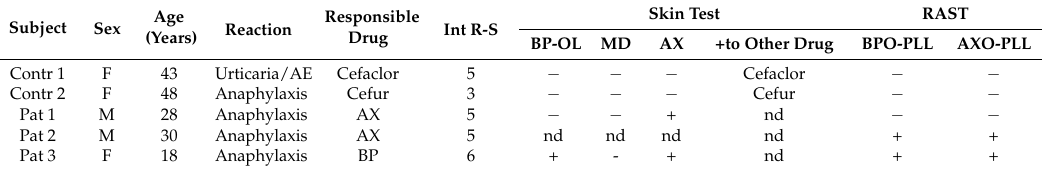
Table 2. Classification and clinical characteristics of controls and patients diagnosed with an immediate allergic reaction to AX included in the